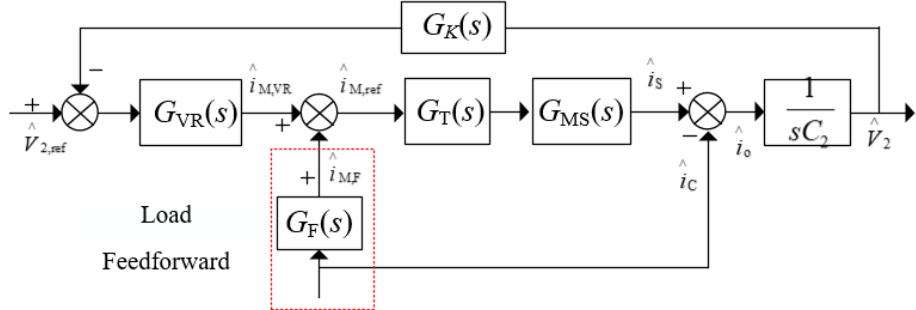
Figure 5. Small signal model of an IBDC with the double-closed-loop control strategy.